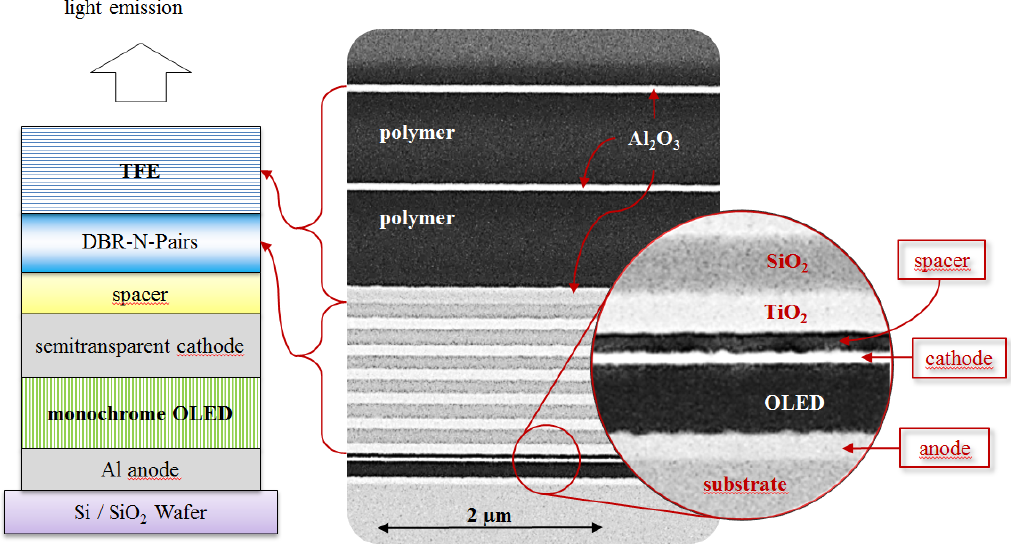
Figure 4. Schematic presentation of the device architecture including the top-emitting OLED, the DBR and the thin film encapsulation. N correlates to the number of DBR pairs ( N = 0, 2, 4,